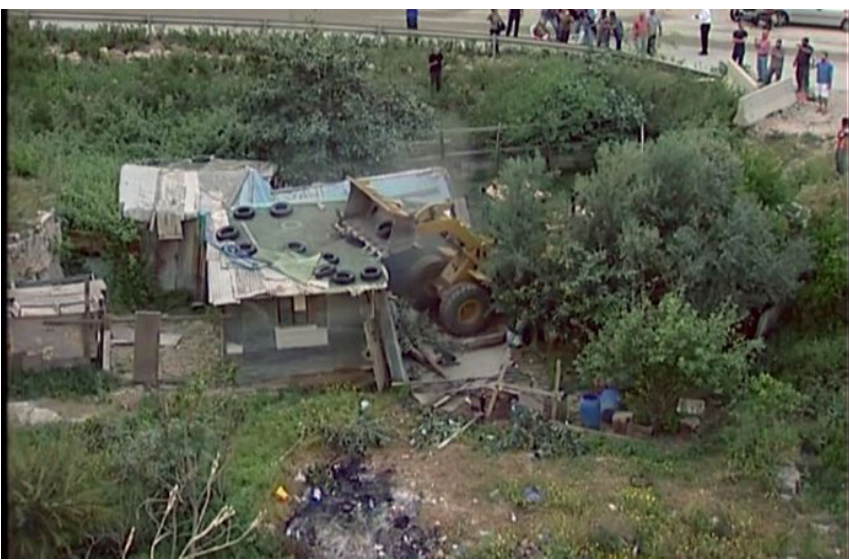
Figure 12 shack of Yousuf and Amna, right before demolition, Source: 'Roshmia', Salim Abi-Jabel, 2015